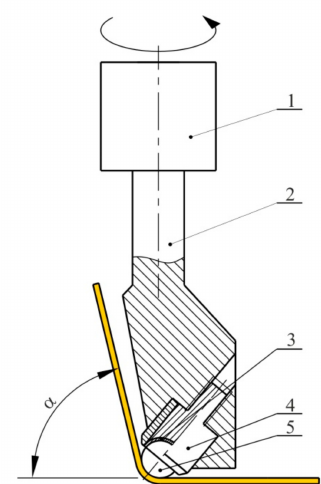
Figure 29. Schematic representation of the ORB test: c—CNC spindle, 2—tool arm, 3—ball bearings, 4—ball cup, 5—roller ball; prepared based on